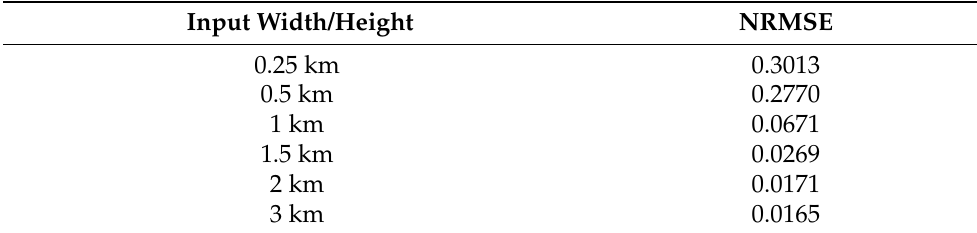
Table 2. Field of view comparison. Absolute accuracy improved as field of view increased despite loss in visual resolution and confounding factors that favored smaller fields of view. Error is given as RMSE in normalized coordinates